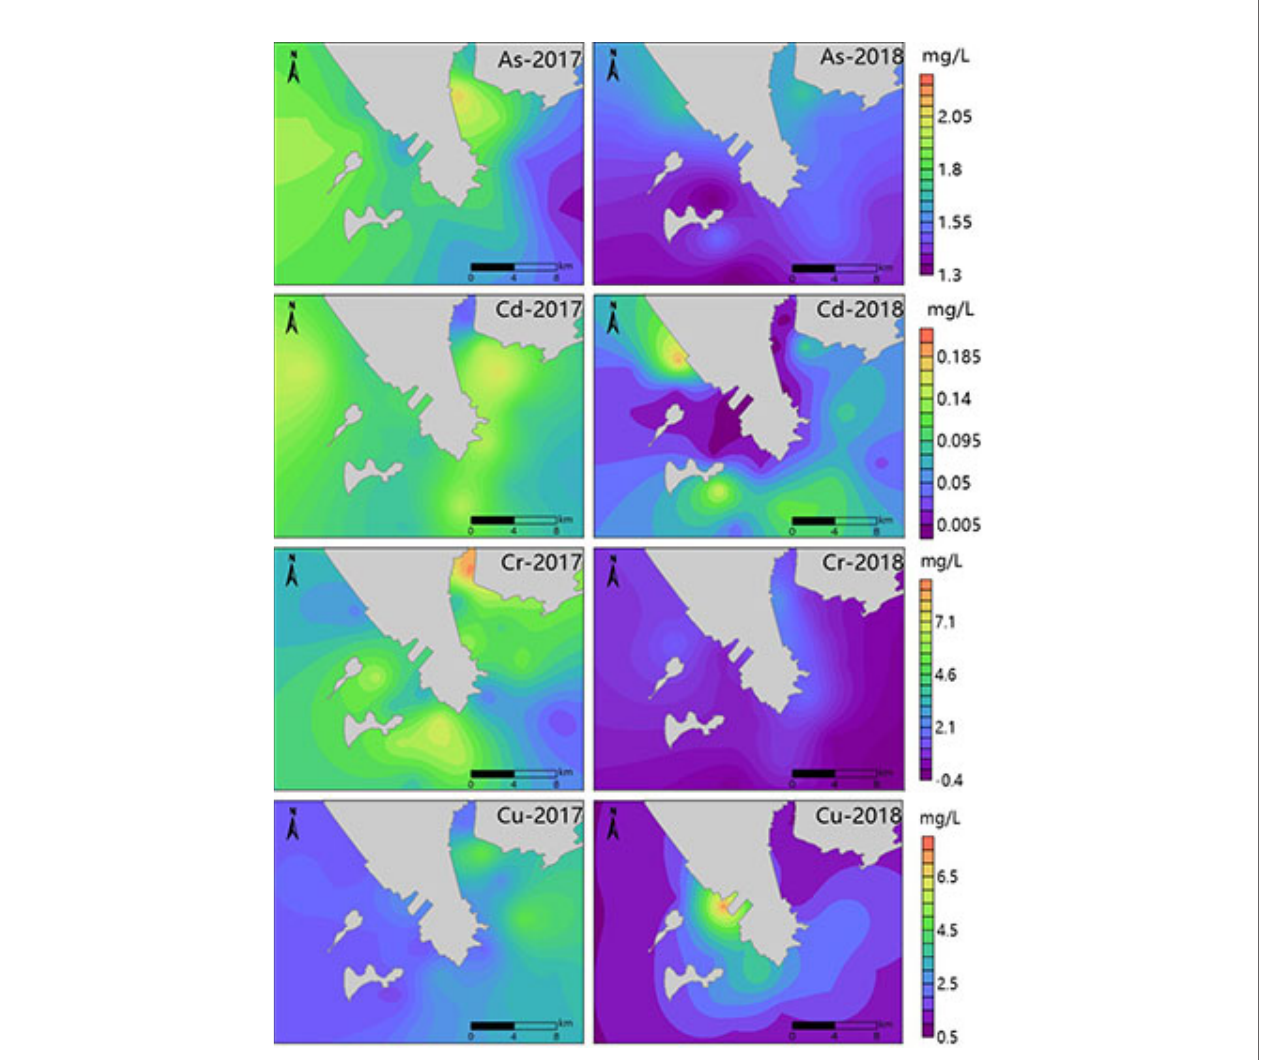
FIGURE 2 | The spatial distribution of As, Cd, Cr and Cu in